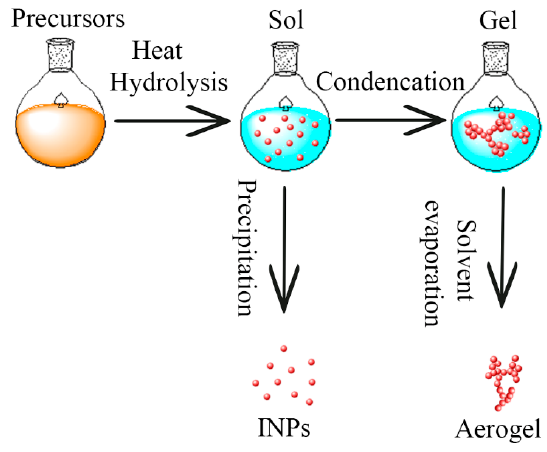
Scheme 5. Schematic illustration of a sol-gel reaction.